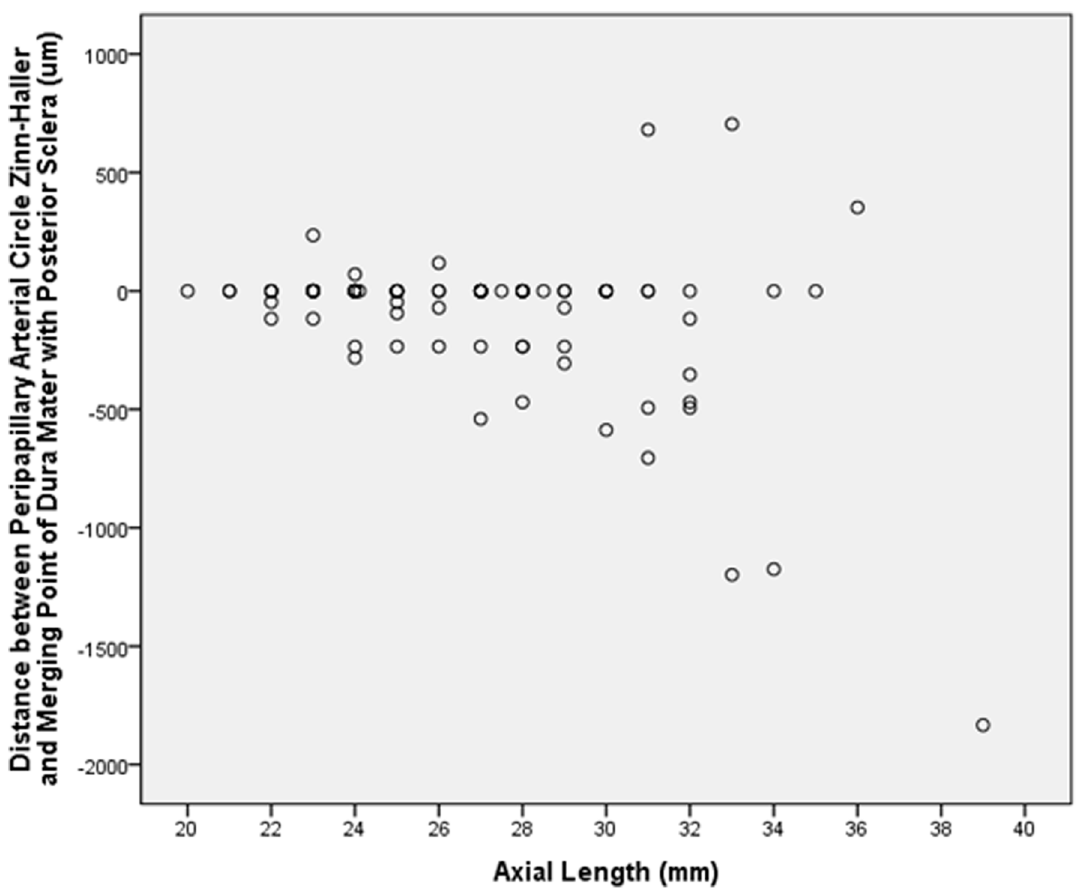
Figure 4. Graph showing the distribution of the distance between the peripapillary arterial circle of Zinn-Haller (ZHAC) and the merging point of the optic nerve dura mater with the posterior sclera in relation to axial length. Negative values mean location of the ZHAC between the merging point and the peripapillary ring; positive values mean ZHAC location peripheral to the merging point.